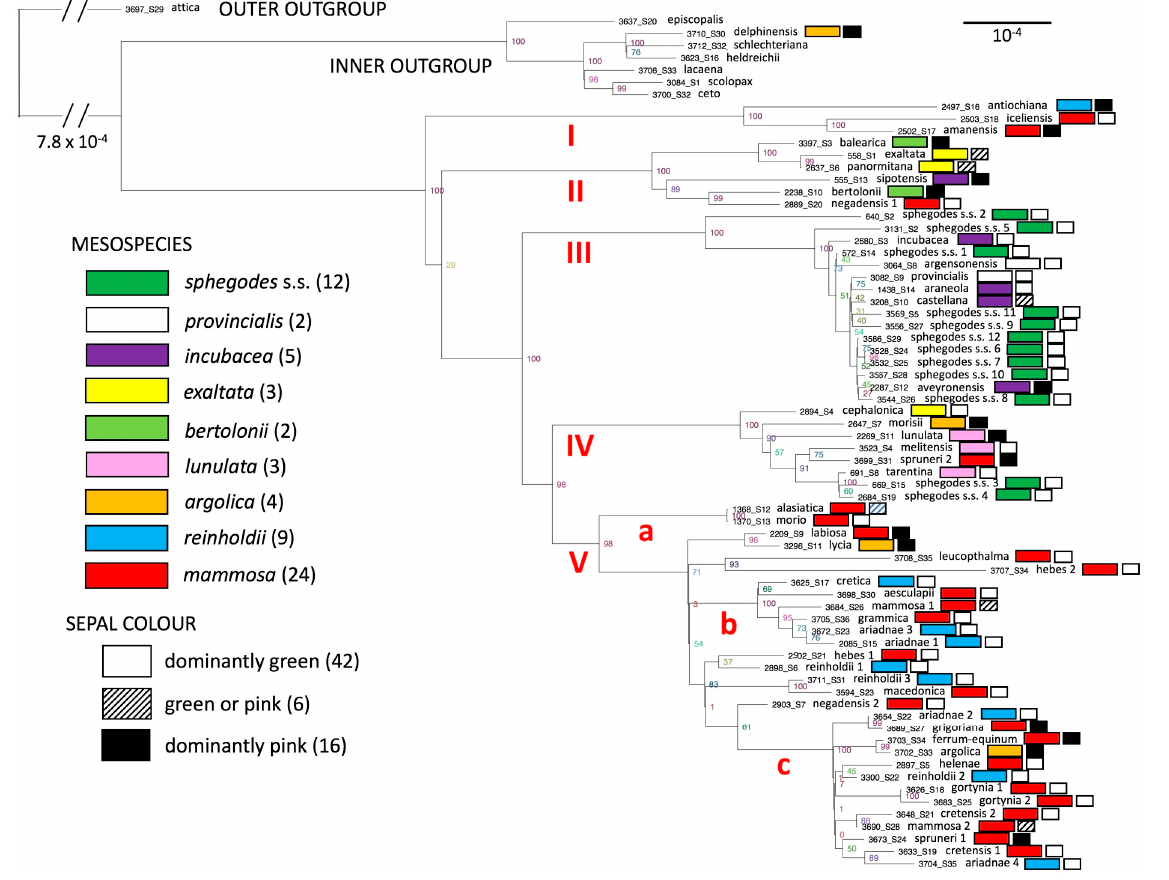
Figure 18. Maximum likelihood phylogeny of whole plastomes obtained via genome skimming from 64 individuals representing 40 microspecies of macrospecies Sphegodes, together with six individuals of macrospecies Fuciflora (‘inner outgroup’) and one individual of macrospecies Umbilicata (functional ‘outer outgroup’). Plants are named according to microspecies, and box-labelled according to both mesospecies attribution and the dominant colour of their sepals. Roman numerals and lower-case letters indicate the main haplotype clusters and subclusters within macrospecies Sphegodes. Figures supporting nodes are bootstrap percentages. Topology from Bateman et al. [45]. Like flower colour, labellum pattern has also been subjected to experimentation. La-